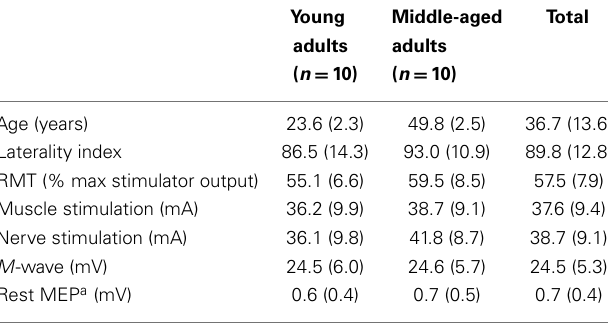
Table 1 | Subject characteristics displayed in mean ±